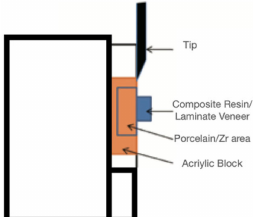
Figure 4. Universal Test Machine using simulation with the